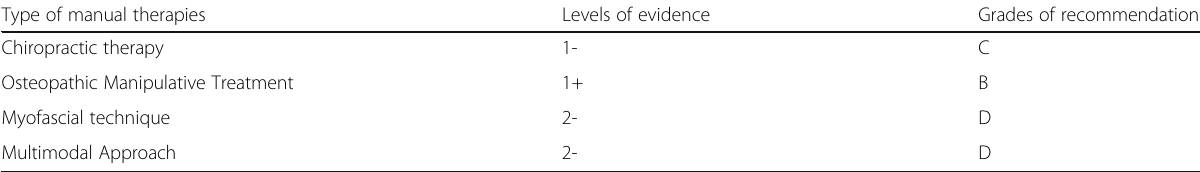
Table 2 - Summary table of levels of evidence [181] and grades of recommendations of manual therapies for primary headaches Type of manual